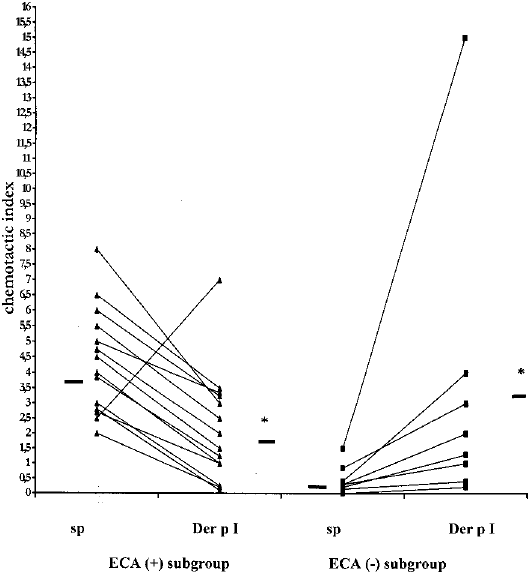
FIG. 2. ECA generation by mononuclear cells (MNC) from healthy non-atopic subjects. * P < 0.05 compared with sponta- neous release. Sp.–spontaneous release; PHA–stimulation release. Mean